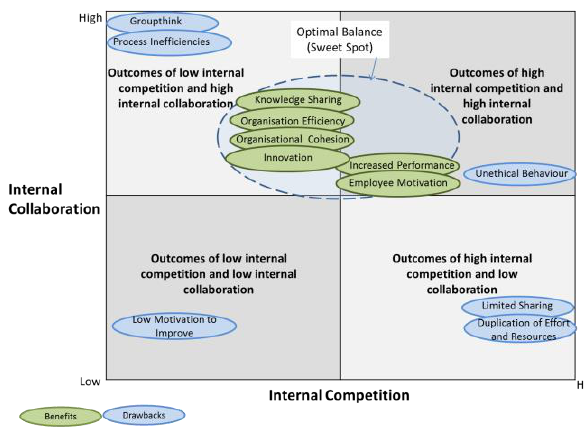
Figure 5: The internal competition and internal collaboration hybrid